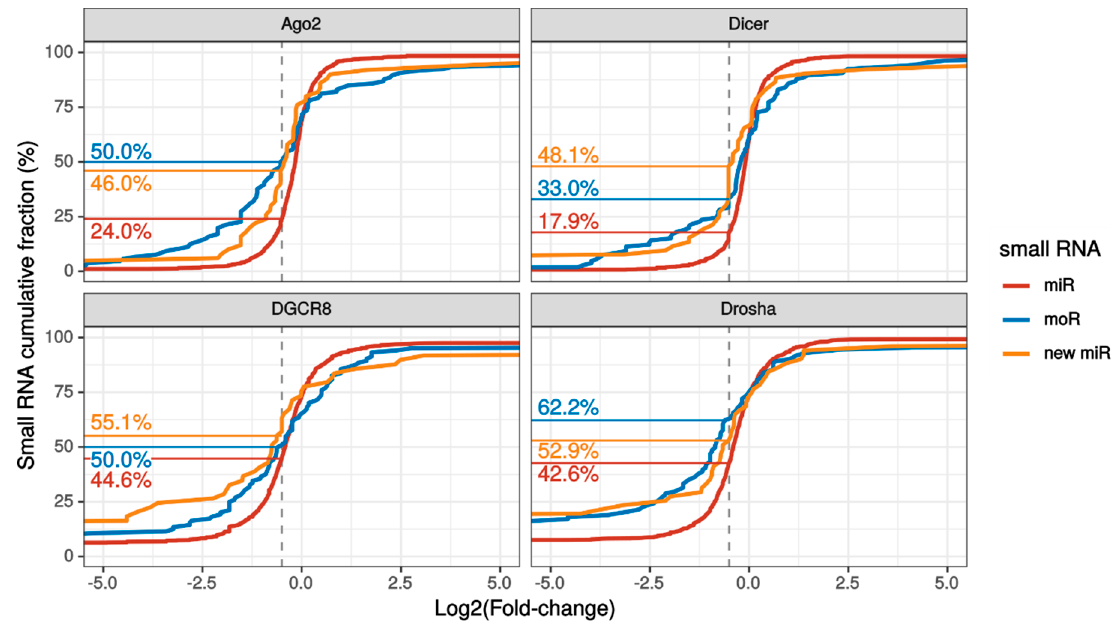
Figure 3. Small RNA expression variation upon knockdown of the miRNA biogenesis pathway. Cumulative fraction of known miRNAs (red lines), moRNAs (blue lines) and novel miRNAs (yellow lines) with the indicated or lower log2 fold change (LFC) with respect to control sample, upon knockdown of either Argonaute2 (Ago2), Dicer, Drosha or DGCR8 in SH-SY5Y cells. The vertical dashed grey lines indicate the LFC threshold for which the down-regulation was substantial (i.e., > 30%). The fractions of substantially down-regulated sRNAs are reported on the left side, following the horizontal lines. This plot focuses on LFC between -5 and +5 to better appreciate the different slope of the cumulative lines close to the substantial downregulation LFC threshold. Plot of LFC full range values is reported in Figure S4.